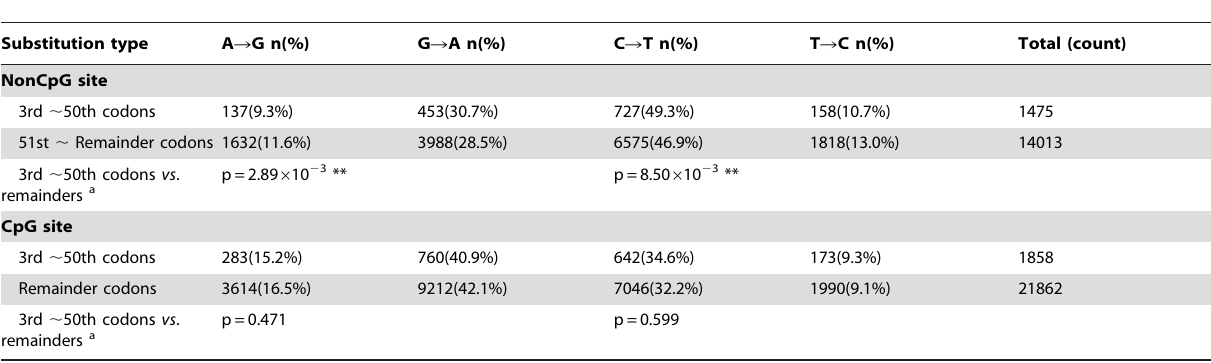
Table 1. A « G and C « T fourfold degenerate site sSNPs.